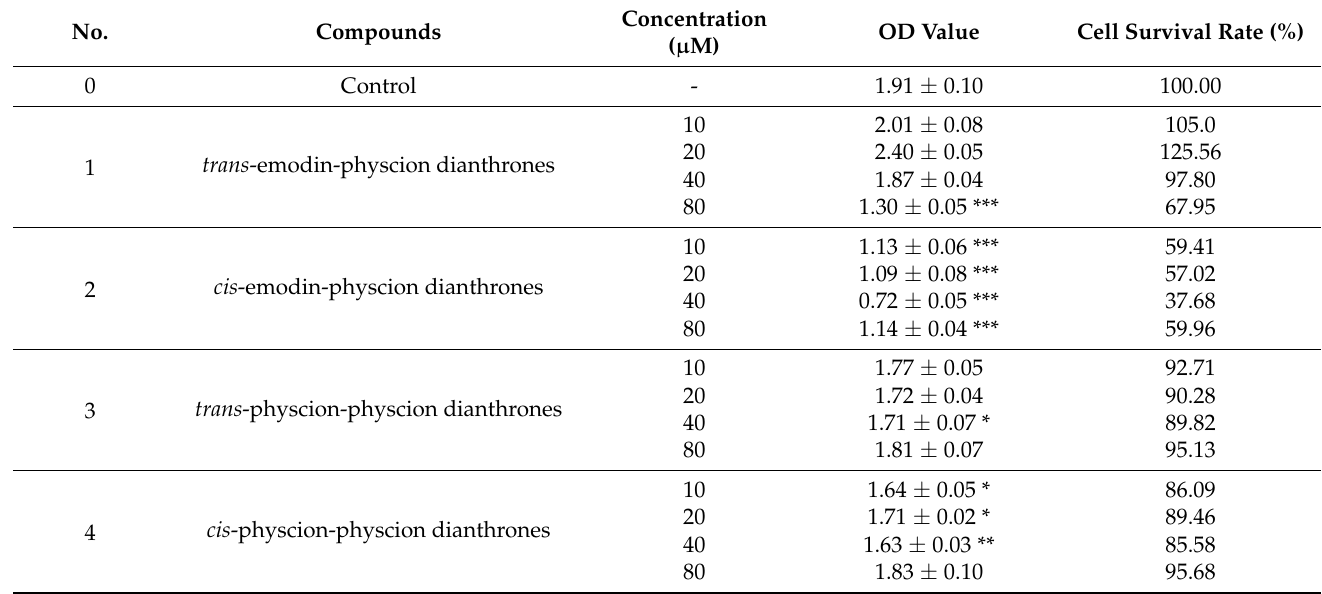
Table 5. Cytotoxic effects of dianthrone exposure in HepG2